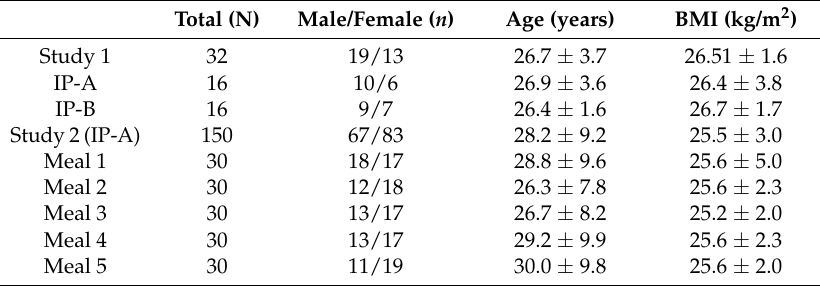
Table 1. Characteristics of the two study populations.